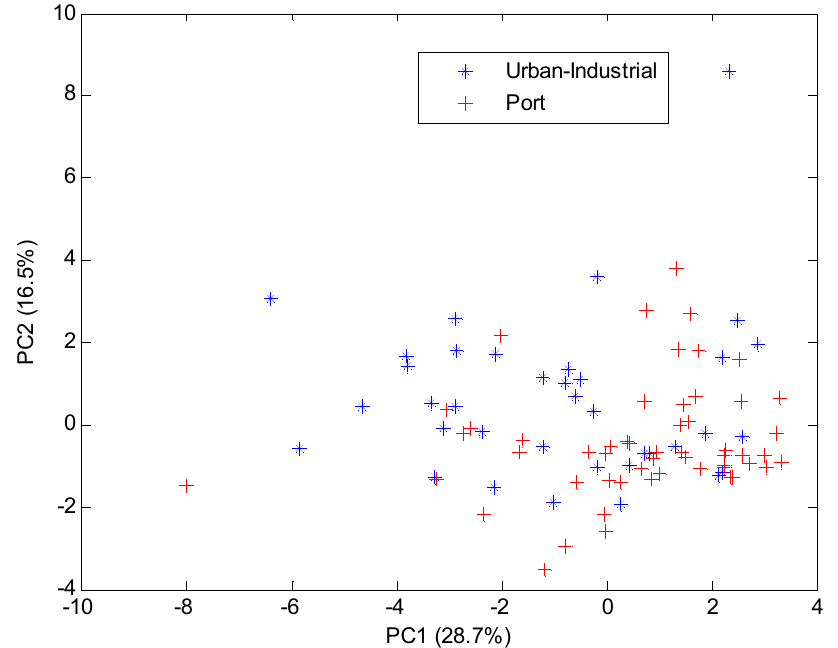
Figure 3. Score plot in the plane of the first and second Principal Components. Blue numbers indicate samples collected when the prevalent wind directions were from urban and industrial area; red numbers indicate samples collected when the prevalent wind directions were from the port area.